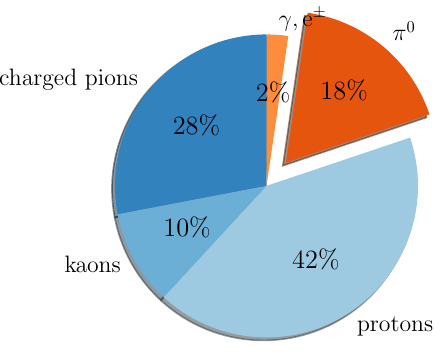
Figure 5. Distribution of the energy among di ff erent groups of particles in the first interaction. Numbers are in percent. Particles in the electromagnetic component are shown in red, particles in the hadronic component in blue. The energy carried by neutral pions is shown in the slightly removed slice. The component labeled ’protons’ corresponds to p, n, Λ and their antiparticles.